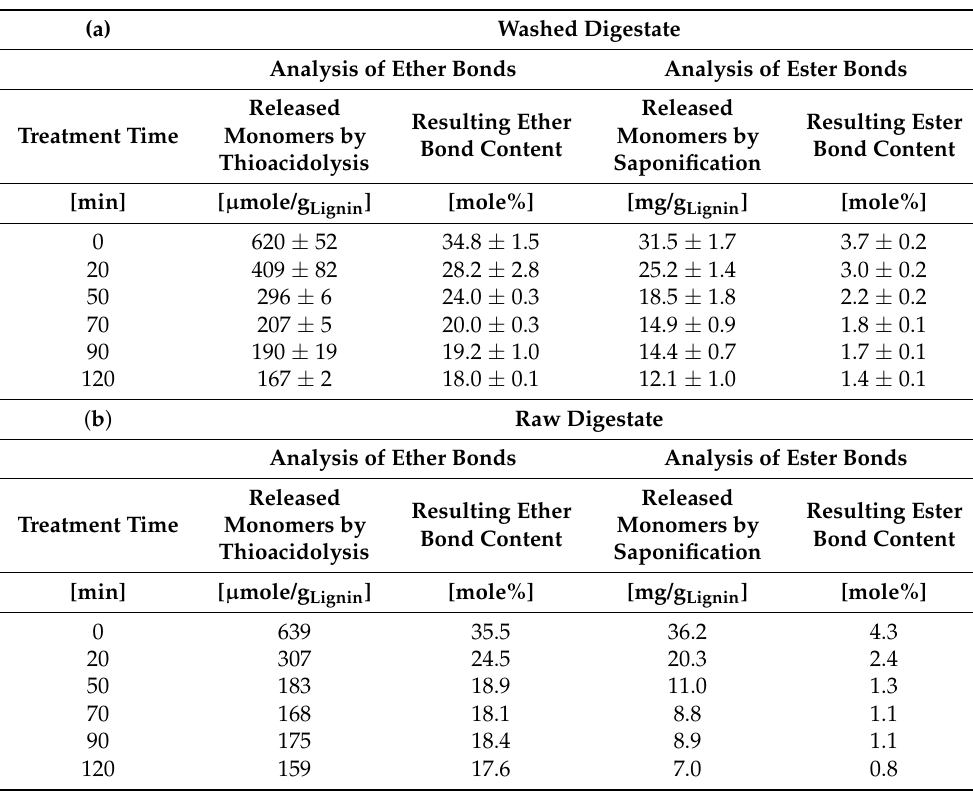
Table A4. Amount of monomers released ( a ) from washed digestate and ( b ) from raw digestate during thioacidolysis and saponification as well as the respective ester and ether bond contents calculated from these results. In ( a ) experiments were conducted as duplicates, in ( b ) they were conducted as single